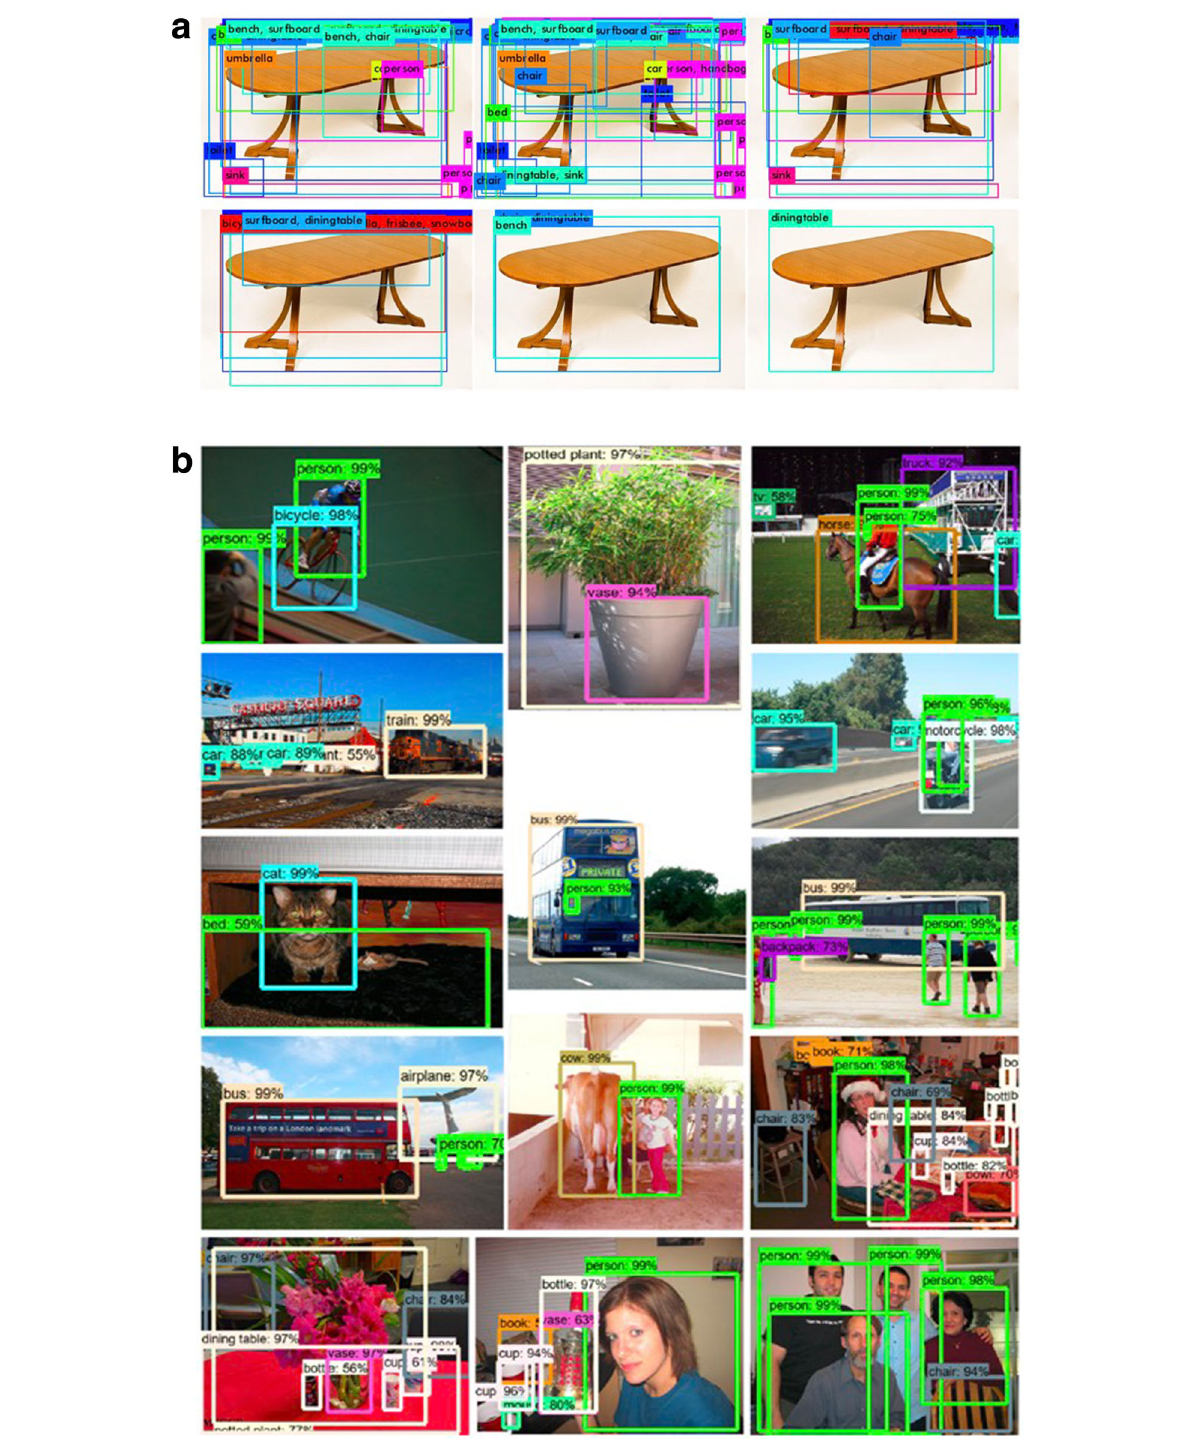
Fig. 6 Some false positives produced in the primary diagnostic unit. a The ulcer sample was detected as plague. b The gray mold sample was detected as ulcer disease. c The low temperature sample was detected as ulcer disease. The detection effect of MS COCO dataset is shown, a the convergence process of boundary box location and object classification, and b the detection effect of SENET512 on COCO